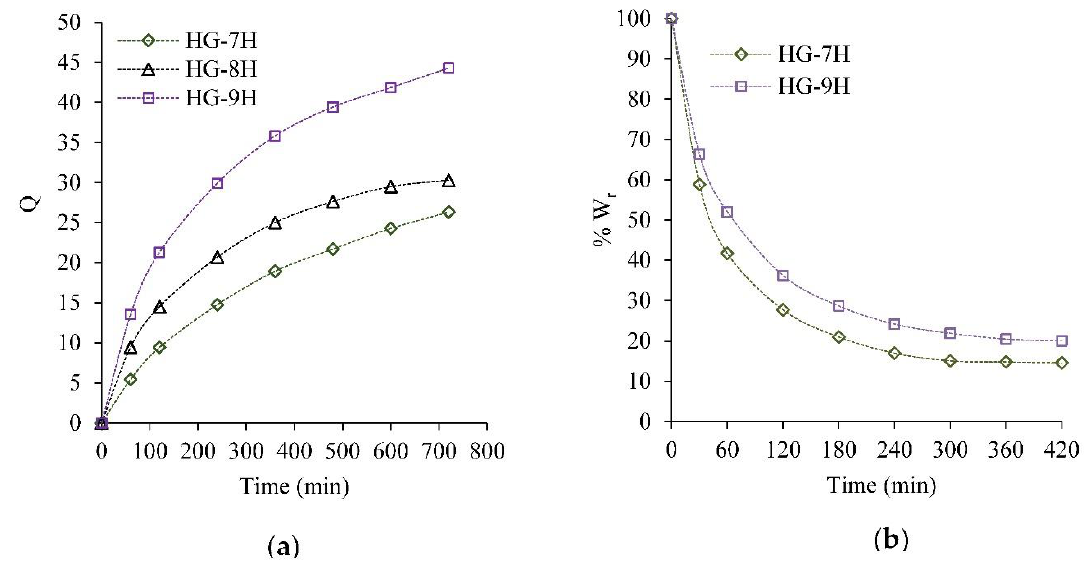
Figure 4. ( a ) Water absorption kinetics (expressed as water absorption degree) at 25 °C for HG-7H, - 8H and -9H, ( b ) water desorption kinetics (expressed as percent of remaining water) at 60 °C for hydrogels HG-7H and